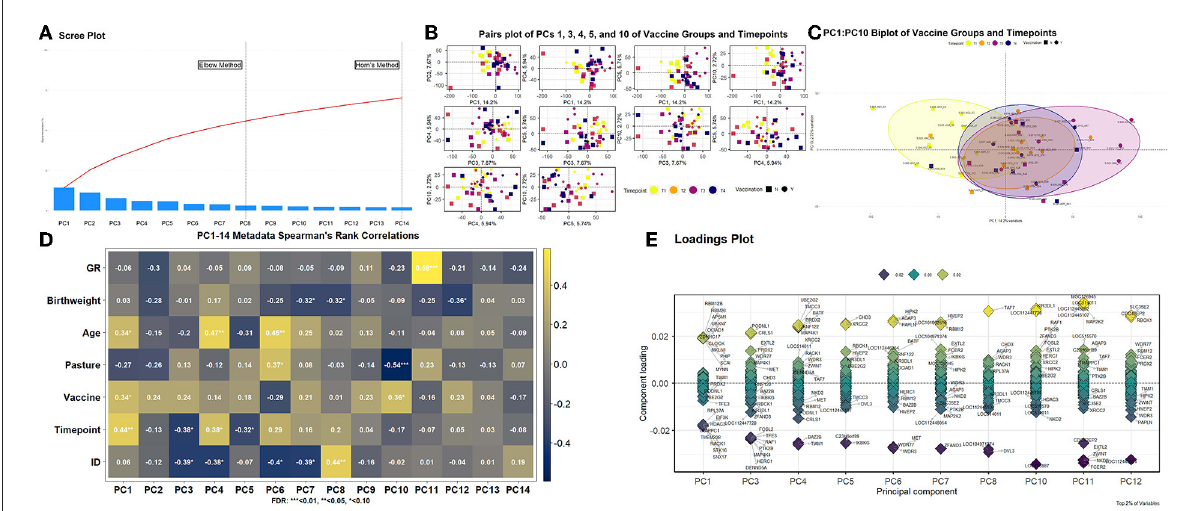
FIGURE3 Principal component analysis of global gene expression patterns for all samples. (A) Scree plot[[Inline Image]] analysis depicting the maximum number of components to retain. Horn’s parallel analysis method was ultimately utilized to retain the first 14 principal components (PCs), which explained 70.15% of total variance across the dataset. (B) Multiple biplot analysis (pairs plot) of PCs possessing significant correlation with timepoint and/or vaccination. Each point (vector) represents a PC score of an individual sample, in which the further from plot-center the point is, the more variation that sample contributes to the total variation. The colors yellow, orange, violet, and blue represent the timepoints T1, T2, T3, and T4, respectively; the shapes square or circle represent the vaccination status as no or yes, respectively. (C) Specific multivariate biplot analysis of PC1 and PC10, as influenced by timepoint and vaccination (see 3B color and shape coding). (D) Spearman’s Rank correlation matrix heatmap of retained PCs and corresponding metadata components. Metadata components included the slope of weight gain over time (i.e., growth rate; GR), weight at birth (Birthweight), age at sampling (Age), pasture assignment (Pasture), vaccination status (Vaccine), time of sampling (Timepoint), and individual identification (ID). (E) Loading plot analysis with associated genes driving the variation explained by PCs with a significant correlation identified by 3D. Only the top 2% of genes based on component loading scores (i.e., most responsible for explained variation) were retained for each